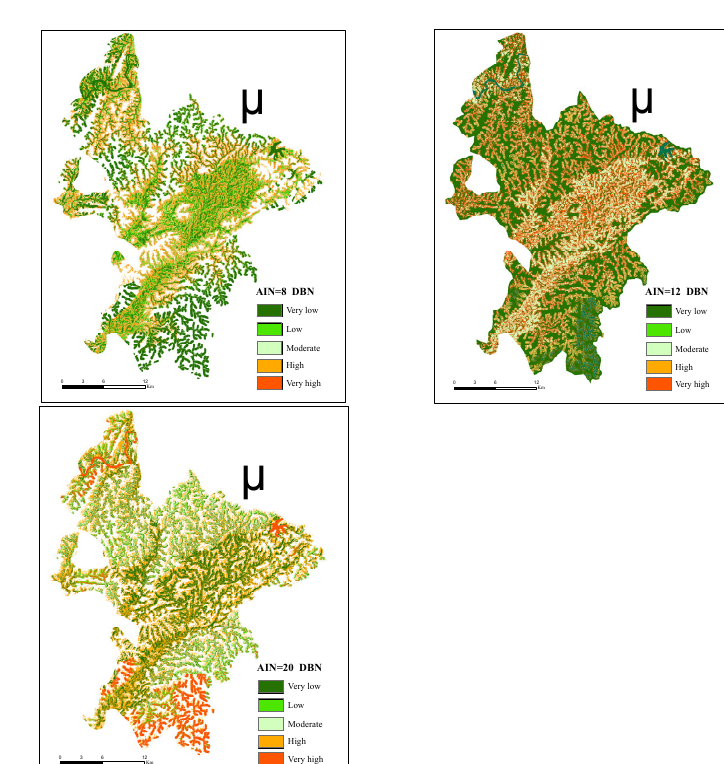
Figure 5. Landslide susceptibility maps of AIN = 8, three di ff erent models.